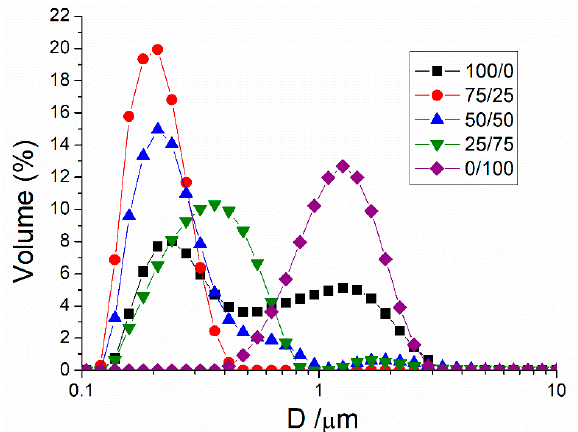
Figure 2. Droplet size distributions for ecological mandarin essential oil emulsions as a function of Tween80 / Span80 ratio.